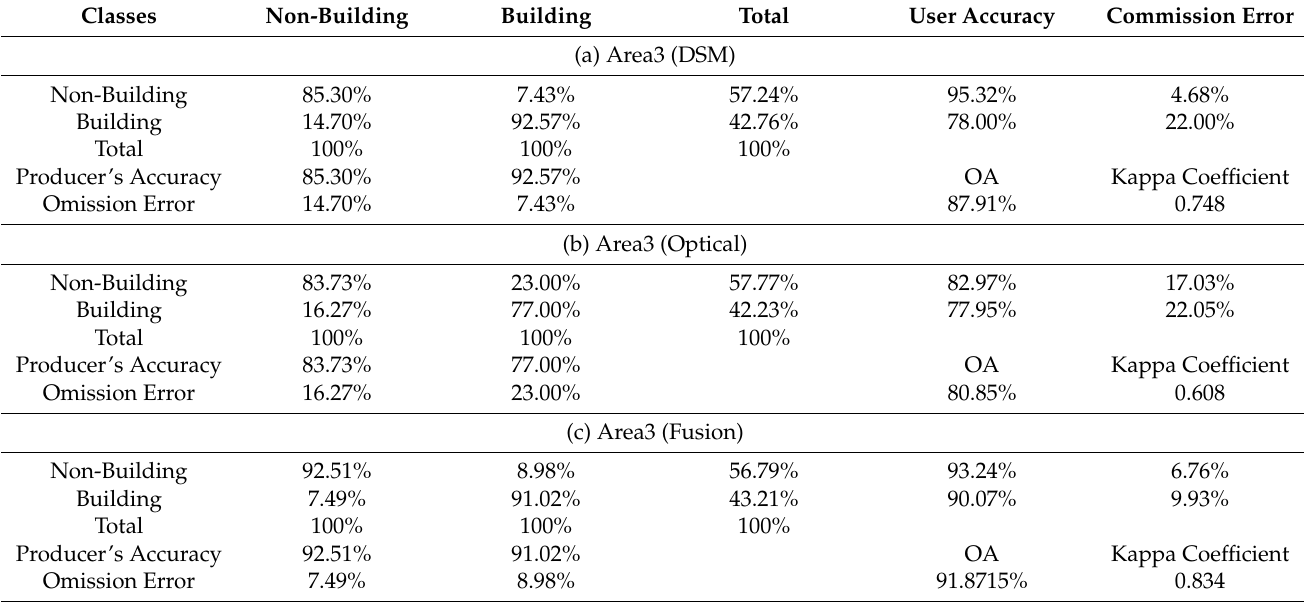
Table 3. The confusion matrix using the proposed method for